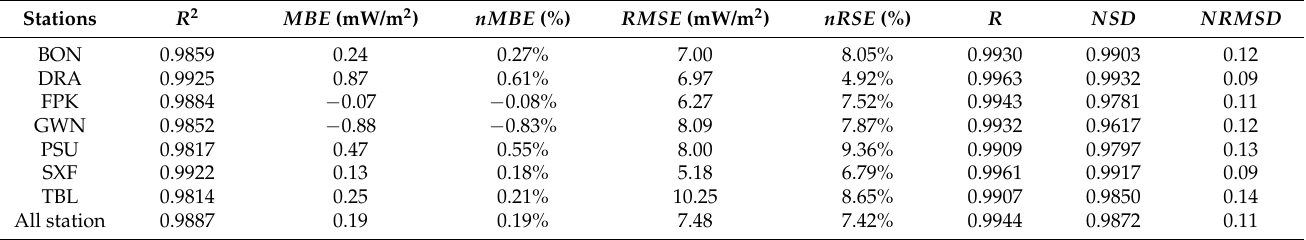
Table 5. Performance evaluation of the DRFCN+RF model on the SURFRAD test set (including the results of the seven stations of SURFRAD and their aggregated